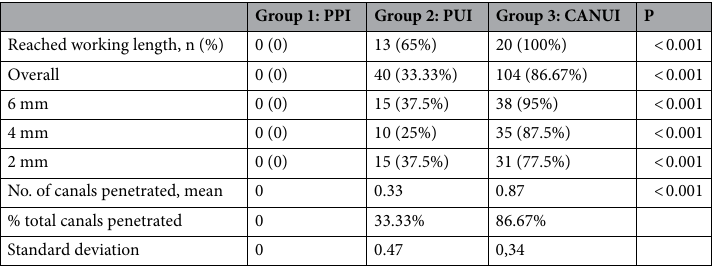
Table 1. Total and percentage of lateral canals penetrated by the irrigation solution in straight root canals.